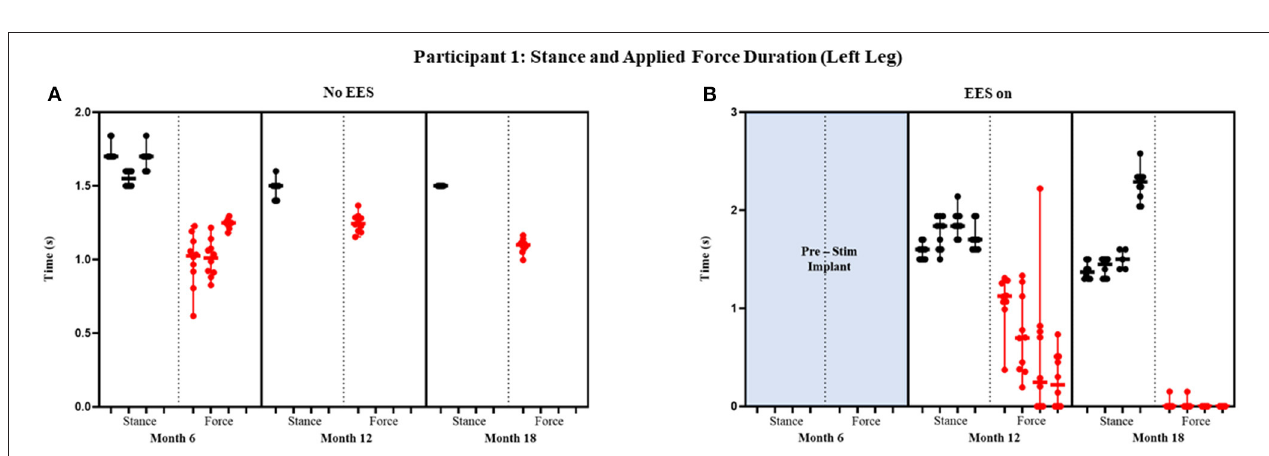
FIGURE 3 | Participant 1: maximum applied force during stance. Maximum applied force during stance phase of the gait cycle with line at the median and range for left leg (A) and right leg (B) . Each tick in the x-axis represents a trial of up to 10 consecutive stance cycles. The dots represent the maximum force for each consecutive cycle where black, red, and blue dots correspond to month 6, 12, and 18, respectively.